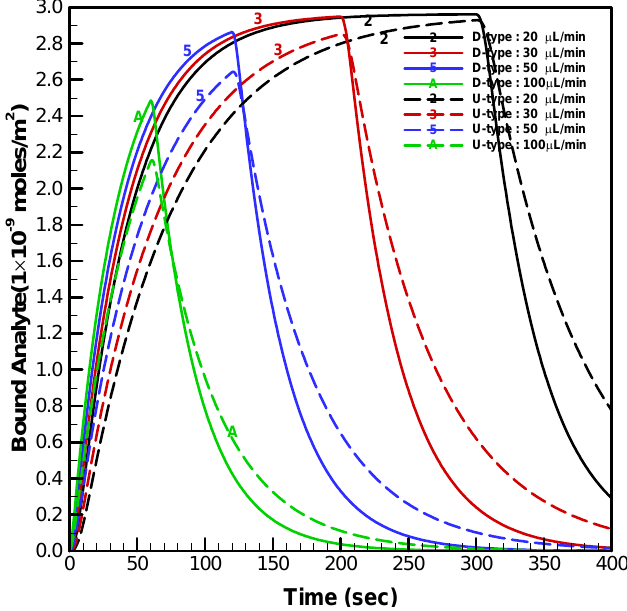
Figure 8. Simulated time histories for the average concentration of bound analyte on the = 6) with different injected flow-rates when the U-type and D-type optical fibers (N g injected volume was fixed at 100 μ